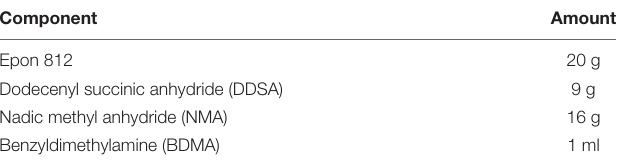
TABLE 3 | Composition of hard Epon